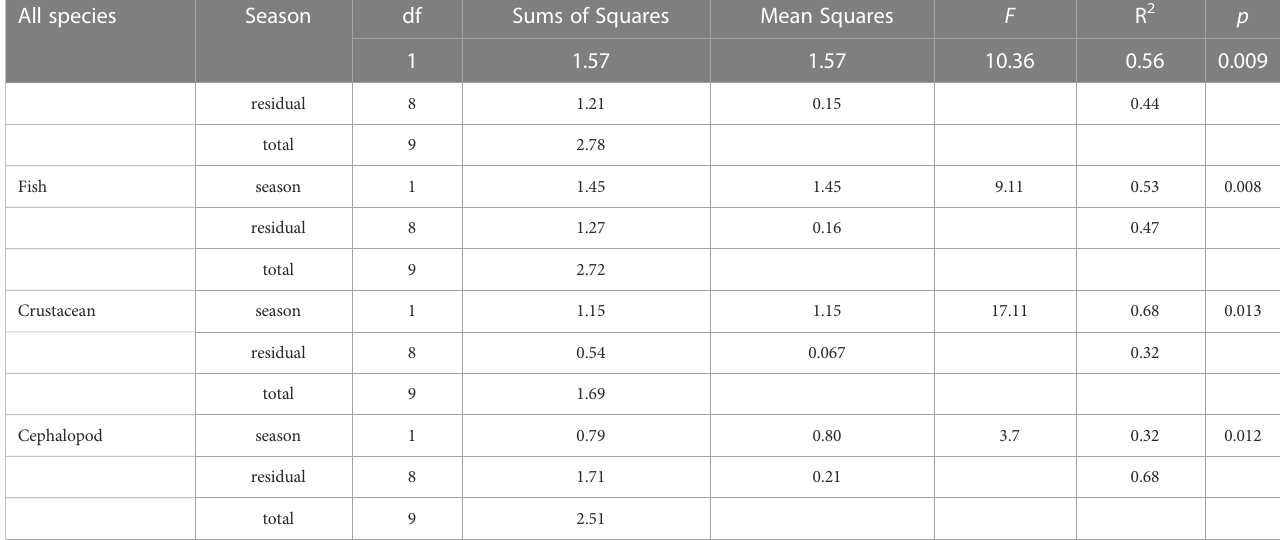
TABLE 1 The statistics of the Per-MANOVA test based on the Bray-Curtis distances of community structure between autumn and spring. All